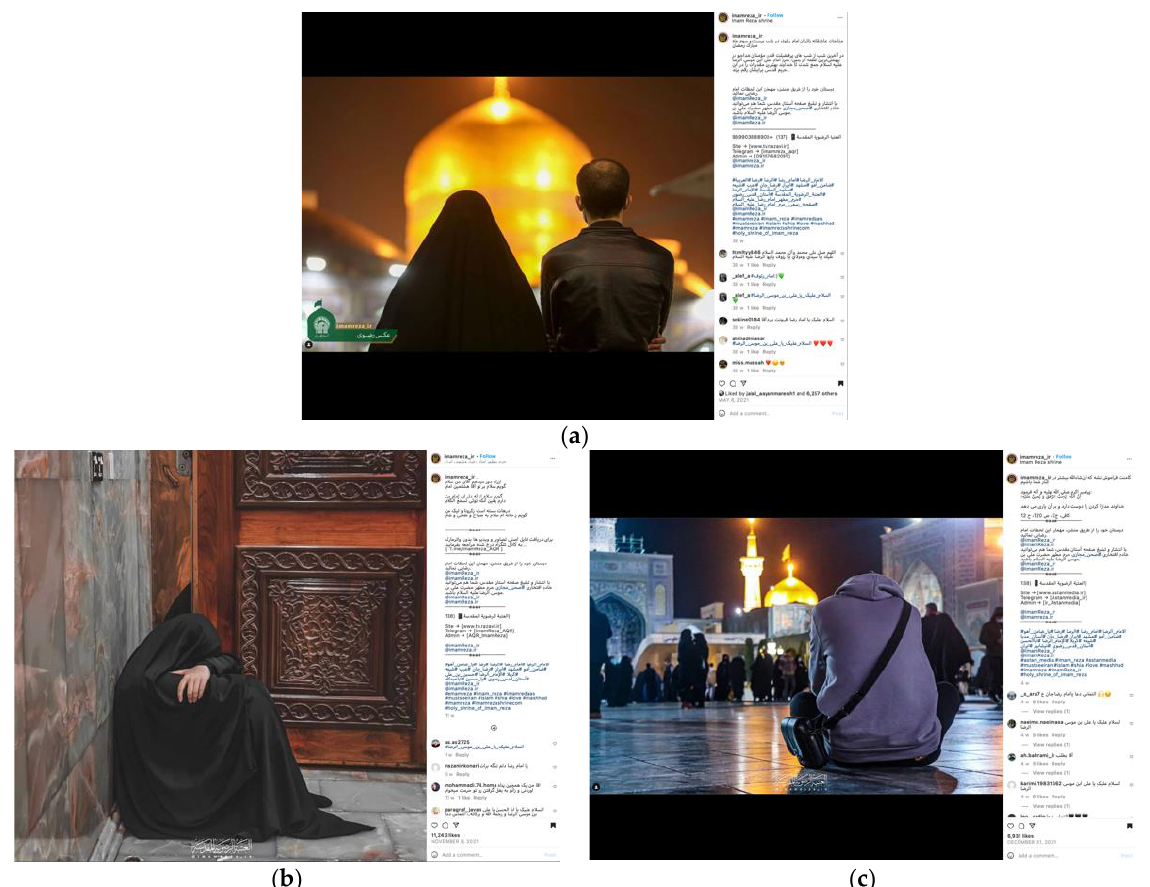
Figure 4. The gestures of ziyarat in the holy shrine framed by @imam_reza Instagram account: ( a ) A gesture of respect and submission in the presence of the Imam Reza’s golden dome; ( b ) A woman leaning against the wall in the holy shrine; ( c ) A man sitting on the ground in a holy court.